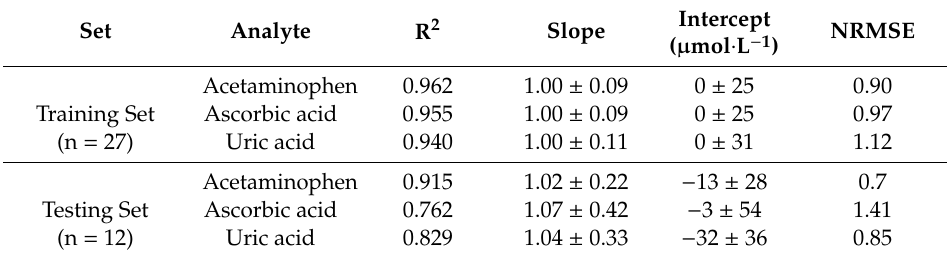
Table 3. Results of the fitted regression curves for obtained vs. expected values, for the training and testing subsets of samples and the three considered compounds (intervals calculated at the 95% confidence level). NRMSE: normalized root mean square